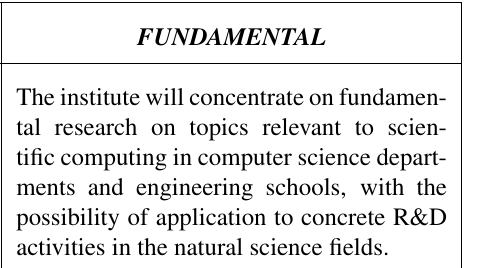
Table 2. 4 main pillars of the software